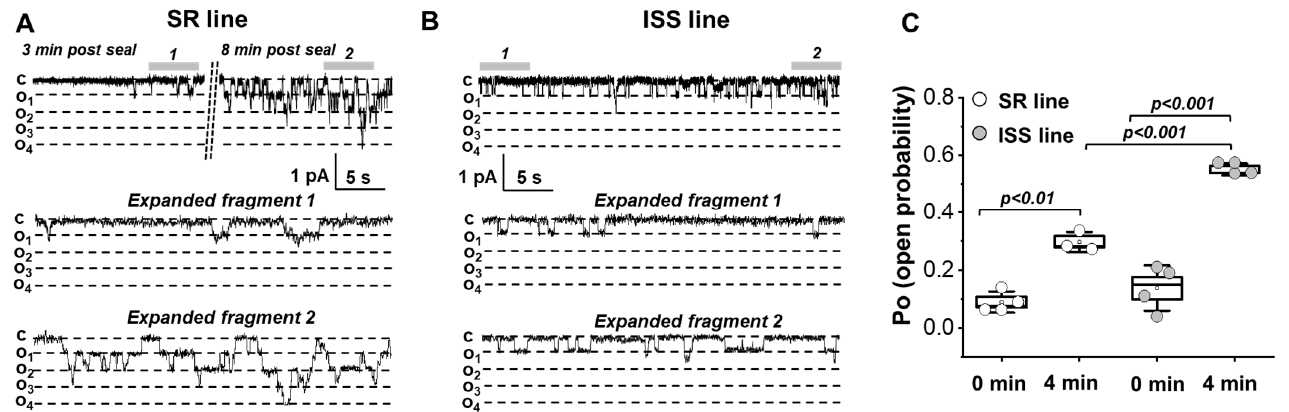
Figure 6. Trypsin-triggered activation of ENaC-like channels in the SR and ISS cells . Representative current traces showing single ENaC-like channel activity in SR ( A ) and ISS ( B ) cell recoded 1 min after GigaOhm seal formation, and 3 min and 8 min post-seal formation; pipette solution contained 2 µg/mL trypsin. Shown are representative recordings as well as expanded regions at − 20 mV and − 30 mV for SR and ISS lines, respectively. Scale bar is noted on the graph, c and oi denote closed and open states (inward currents are downward). ( C ) A summary graph of the open probability of the channels calculated for at least 20 s recordings immediately after the start of the activation of channels (0 min), and 4 min post-activation start (4 min) (SR: 0 min, 0.089 ± 0.018 n = 4 vs. 4 min, 0.297 ± 0.02 n = 3, p < 0.01; ISS: 0 min, 0.138 ± 0.039 n = 4 vs. 4 min, 0.551 ± 0.012 n = 3, p < 0.001, two-way ANOVA, Tukey’s multiple comparisons test).